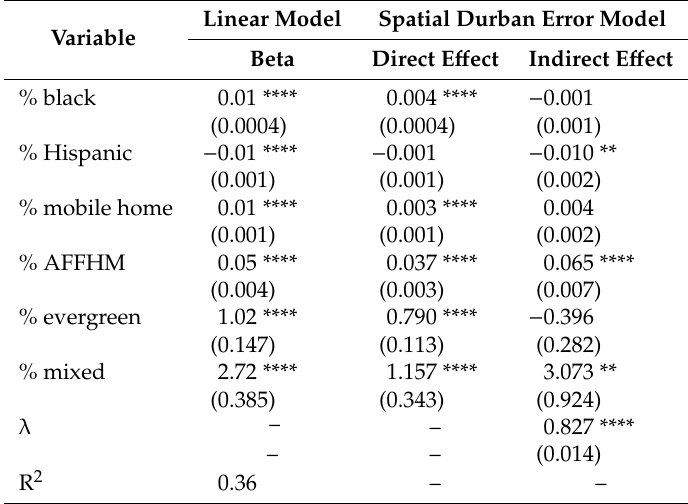
Table 2. Linear Model and Spatial Durbin Error Model. n =